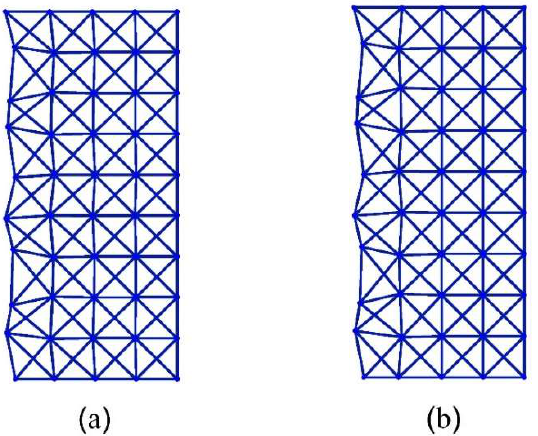
Figure 12. Deformation configurations (scaled) for a half-cyclic domain of the x-braced lattice ( 𝑚 = 0 → 9 , 𝑛 = 0 → 4 ) at k = 0.4714 ( a ), and k = 1.0834 ( b ).